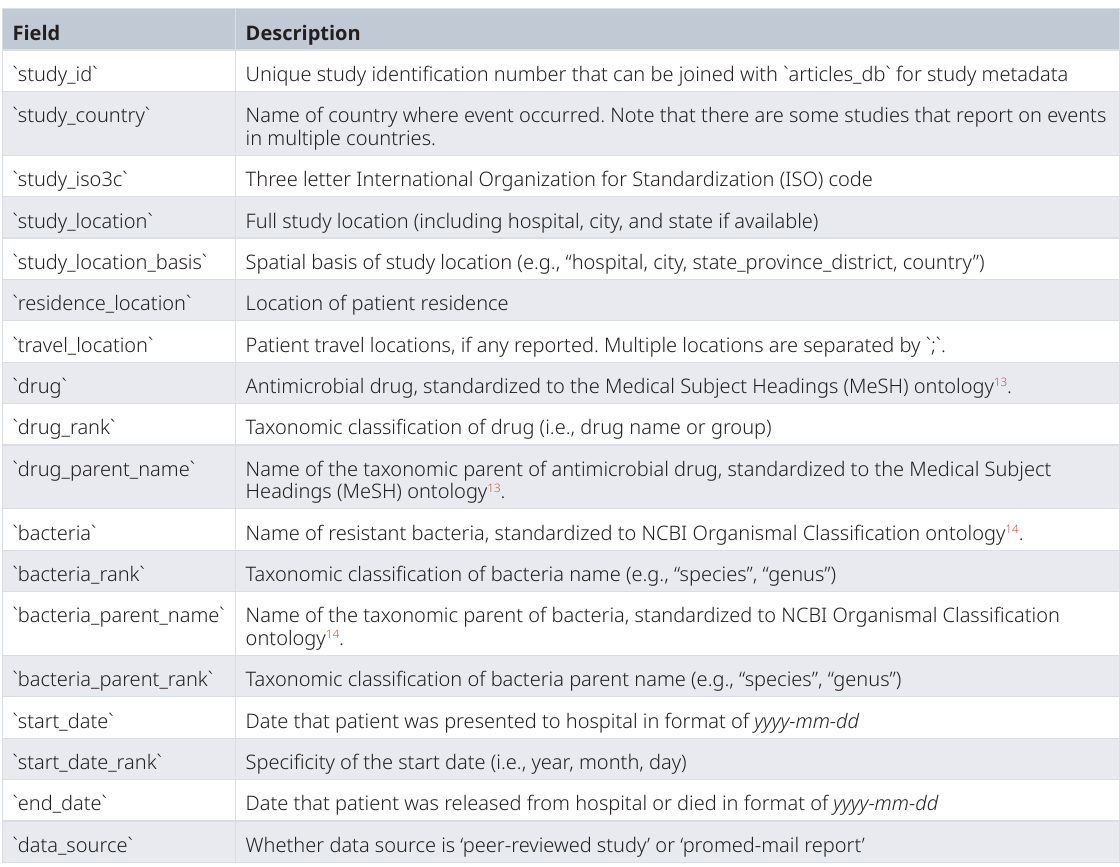
Table 1. Database fields and